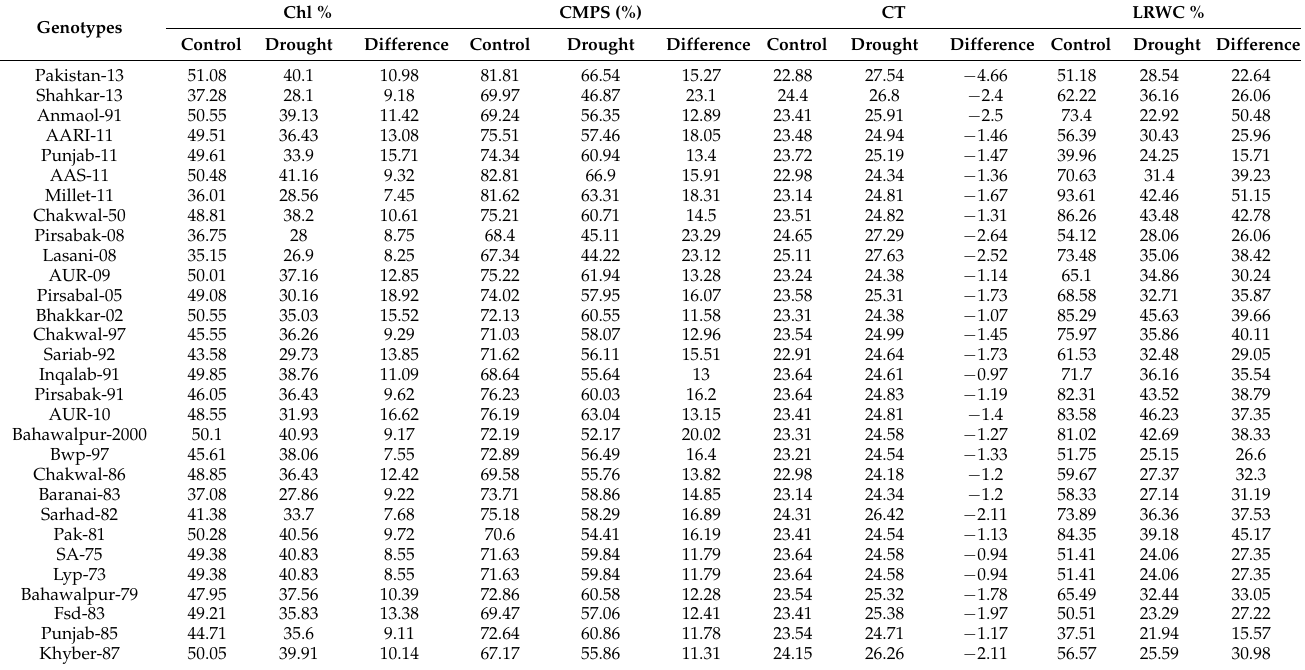
Table 1. Effect of control and water-stressed conditions on physiological parameters of different wheat